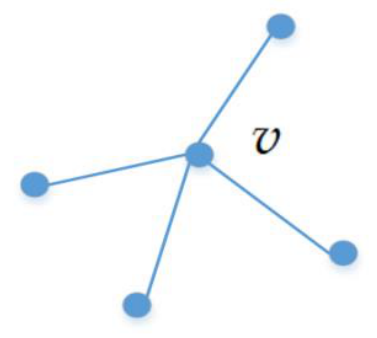
Figure 1. The node v and its neighbourhood.